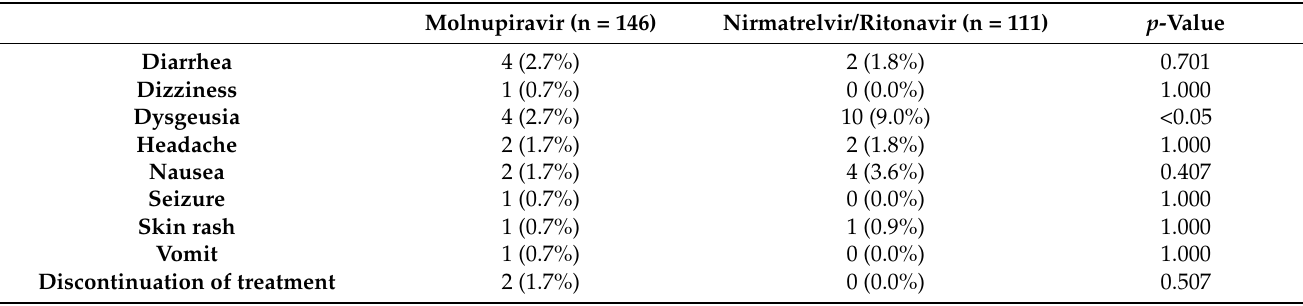
Table 2. Side effects recorded among the included patients and according to treatment